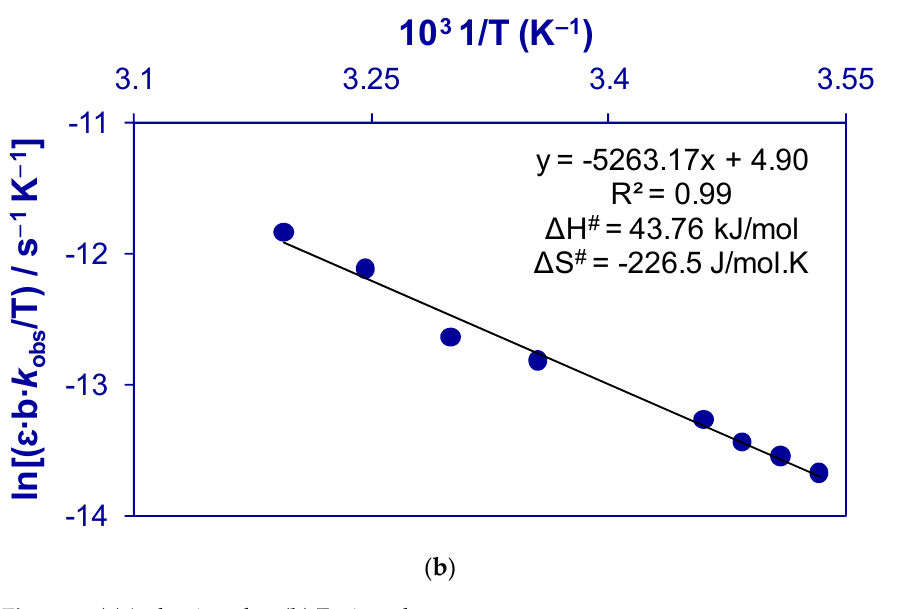
Figure 6. ( a )Arrhenius plot. ( b ) Eyring plot.